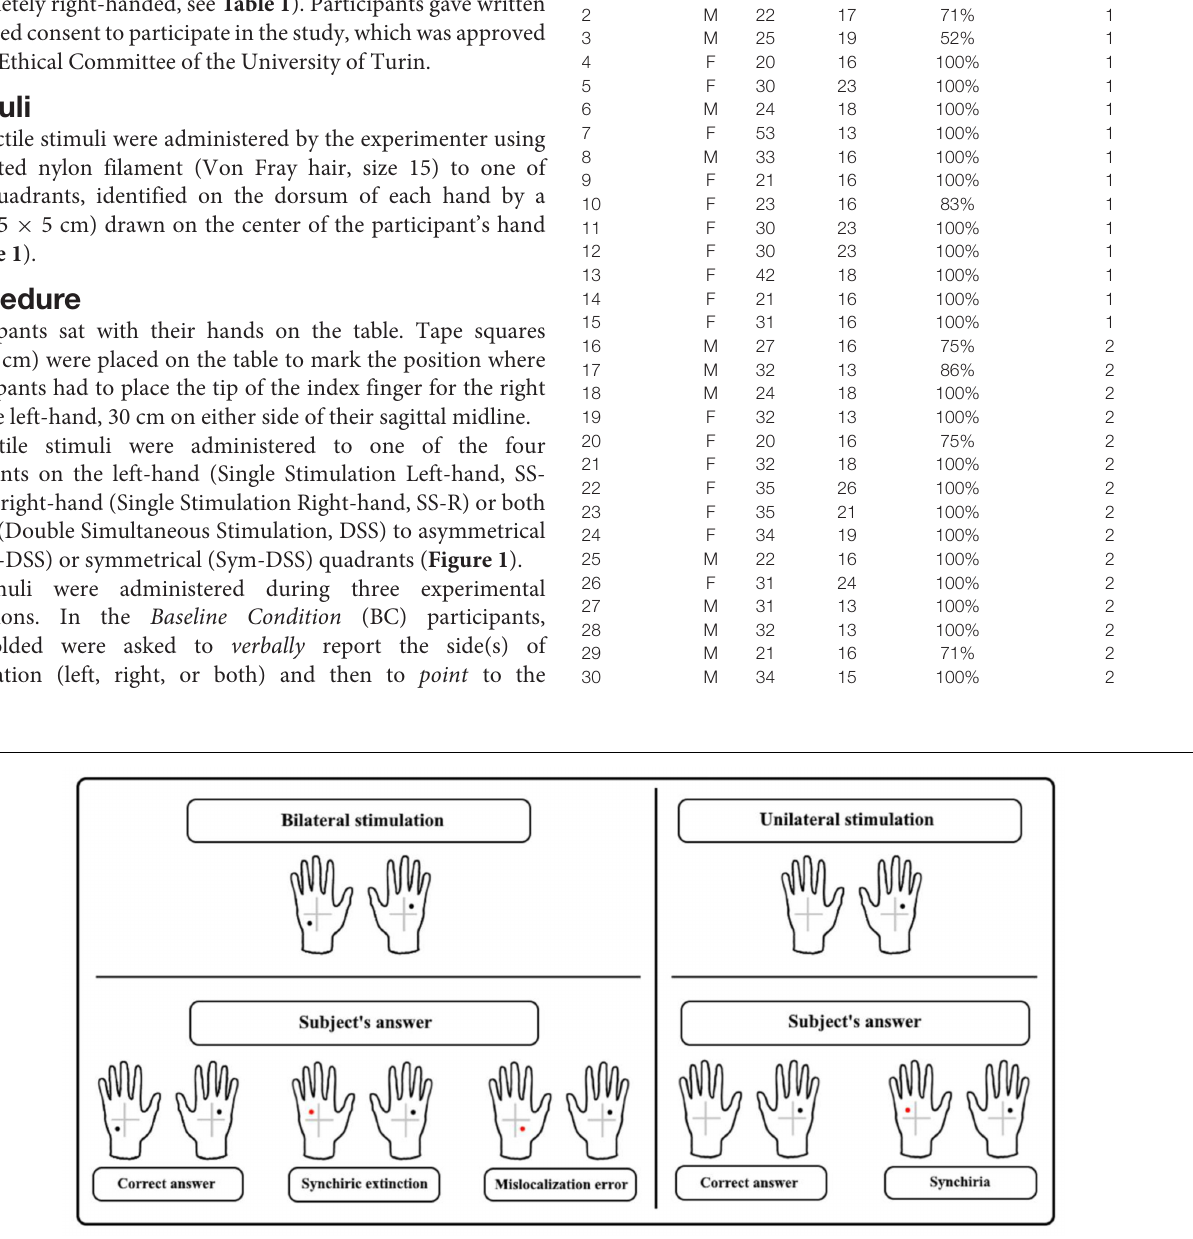
FIGURE 1 | The upper panel shows examples of bilateral asymmetrical tactile stimulation and unilateral stimulation. In the lower panel response, examples are given showing the correct answer and three types of errors: synchiric extinction and mislocalization error regarding bilateral stimulation, and synchiria regarding unilateral